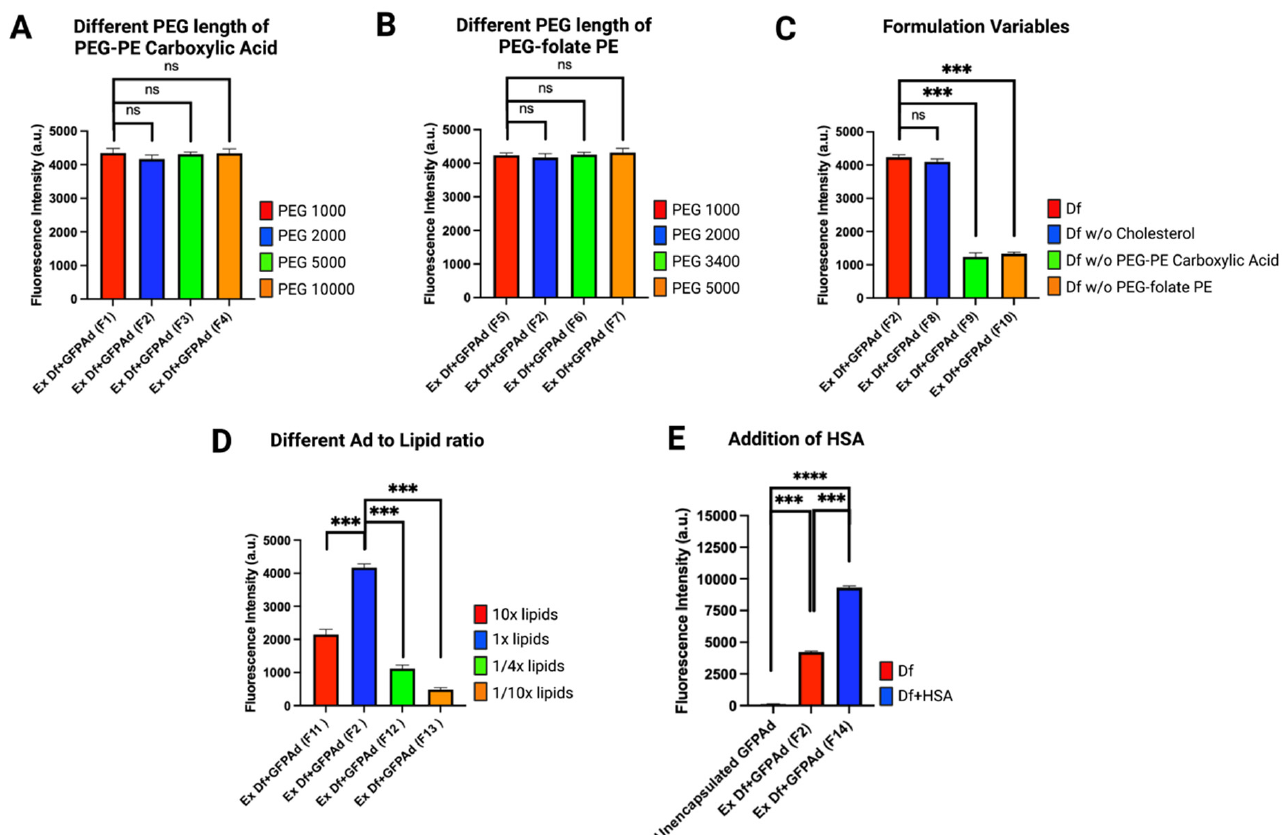
Figure 3. Liposome formulation optimization based on in vitro transduction on CAR deficient CT26 mouse colon cancer cell line at MOI 50 (n = 3): ( A ) Liposomes manufactured with different length of PEG-PE carboxylic acid ( p value: ns = not significant). ( B ) Liposomes manufactured with different length of PEG-folate-PE ( p value: ns = not significant). ( C ) Liposomes manufactured by removing one excipient at a time demonstrating significance of PEG-PE carboxylic acid and PEG-folate-PE ( p value: ns = not significant, *** ≤ 0.001). ( D ) Liposomes manufactured by different Ad to DOTAP lipid ratios ( p value: *** ≤ 0.001). ( E ) Liposomes manufactured by addition of HSA resulting in 100-fold higher transduction compared to the unencapsulated Ad ( p value: *** ≤ 0.001, **** ≤ 0.0001).